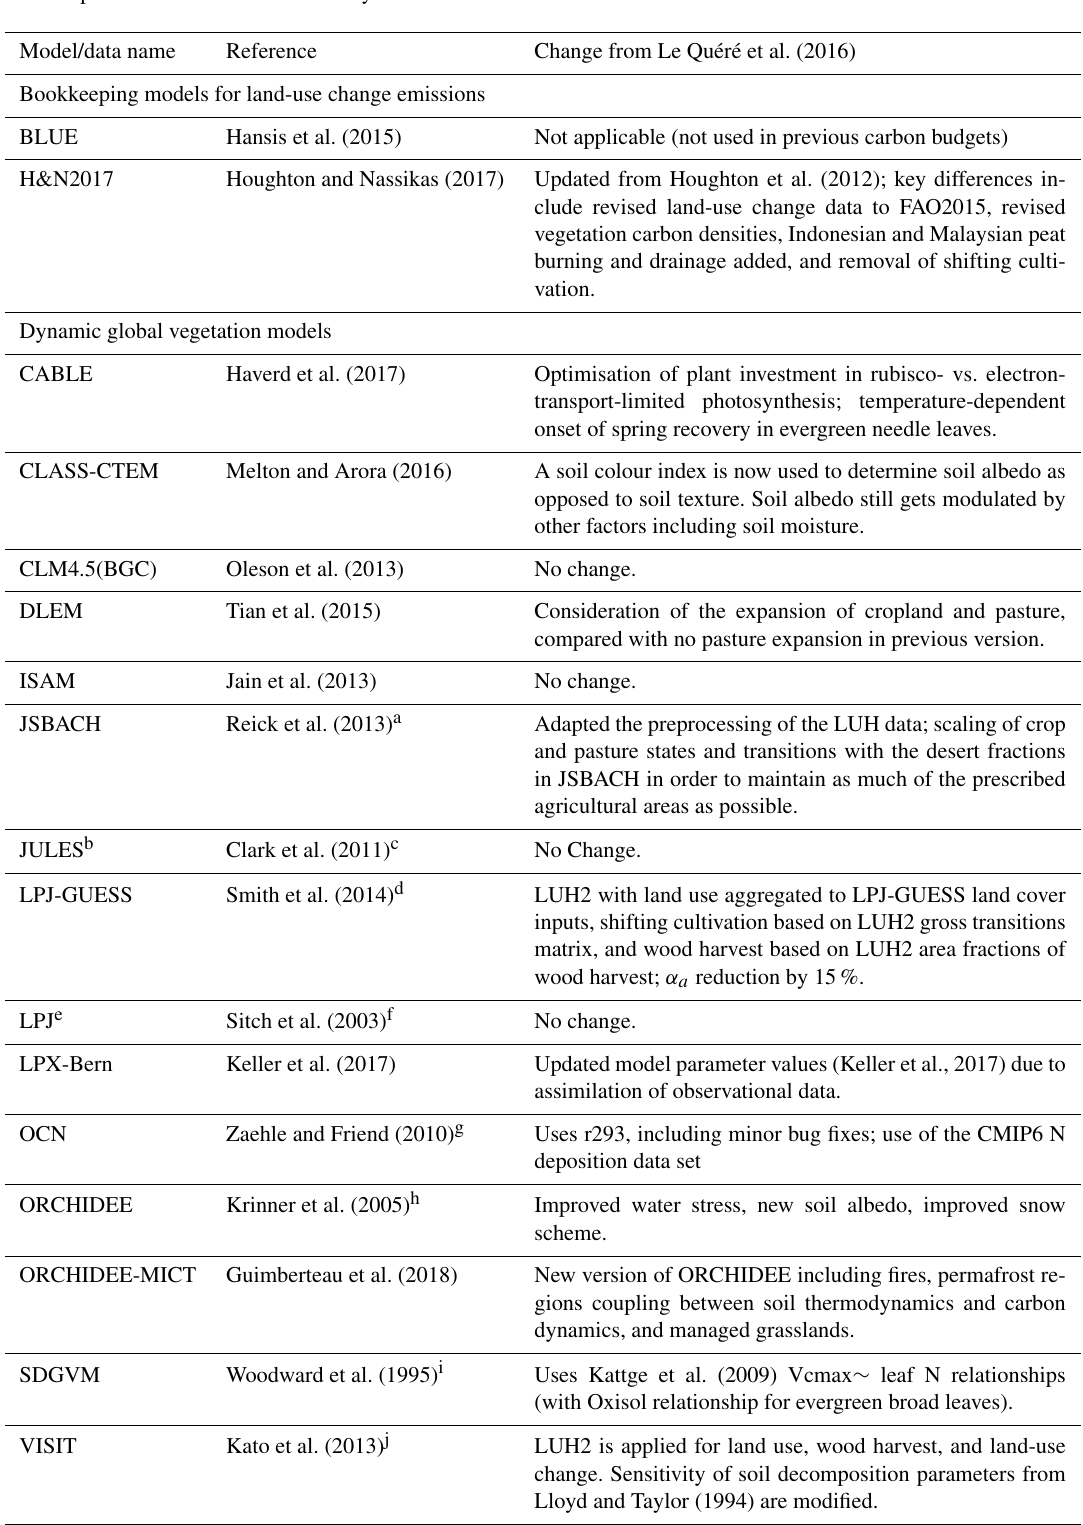
Table 4. References for the process models, p CO 2 -based ocean flux products, and atmospheric inversions included in Figs. 6–8. All models and products are updated with new data to end of year